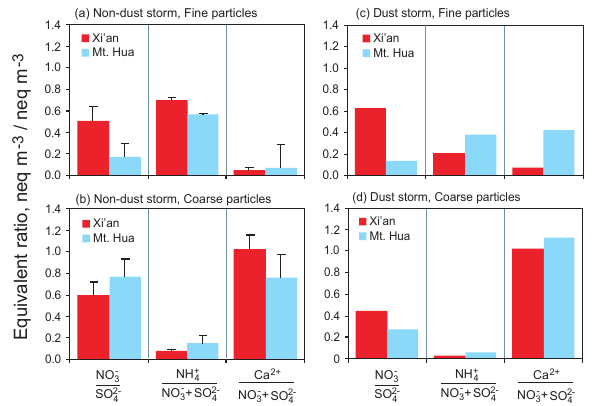
Fig. 11. Equivalent ratios of major inorganic ions in fine ( < 2.1µm) and coarse ( > 2.1µm) particles from Xi’an and Mt. Hua during (a, b) non-dust storm and (c, d) dust storm (24 April 2009, DS II) pe- riods. Figure 11. Equivalent ratios of major inorganic ions in fine (<2.1 µ m) and coarse (>2.1 µ m) particles from Xi’an and Mt. Hua during (a,b) non-dust storm and (c,d) dust storm (April 24, 2009) periods